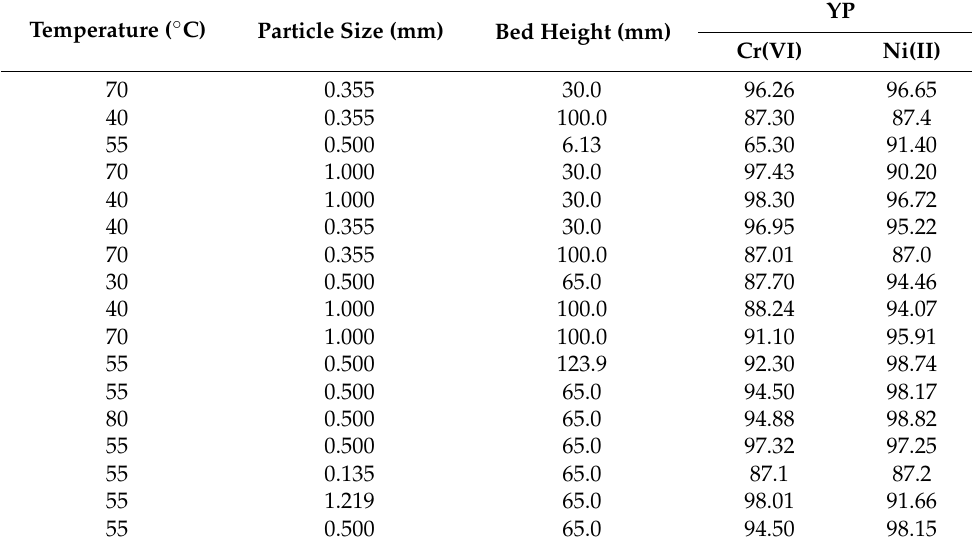
Table 3. Cr(VI) and Ni(II) removal efficiency over YP in a continuous